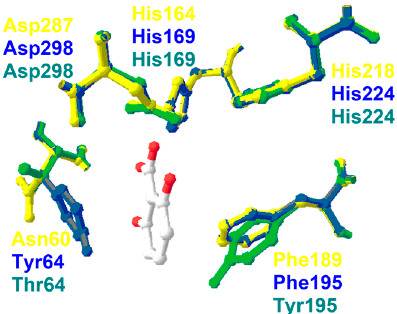
Figure 16. 3D structure of the 2,6-dihydroxybenzoic acid decarboxylase active site cavity showing, in yellow color, the relevant amino acids of the enzyme isolated from Rhizobium sporomusa . [74] The figure also shows: i) In blue color, the predicted amino acids of salicylic acid decarboxylase isolated from Trichosporon moniliiforme [68]; ii) in green color, the predicted amino acids of the double mutant-salicylic acid decarboxylase [70]. 2,6-dihydroxybenzoate (represented in white color) is docked into the cavity. Adapted with permission from [70]. Copyright 2013, The Chemical Society of